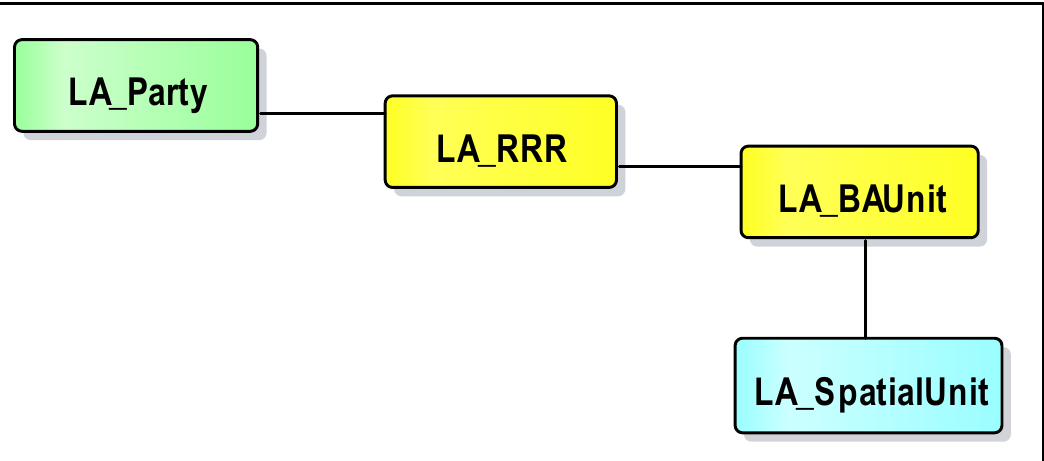
Figure 5. The LADM basic classes. Figure 5.